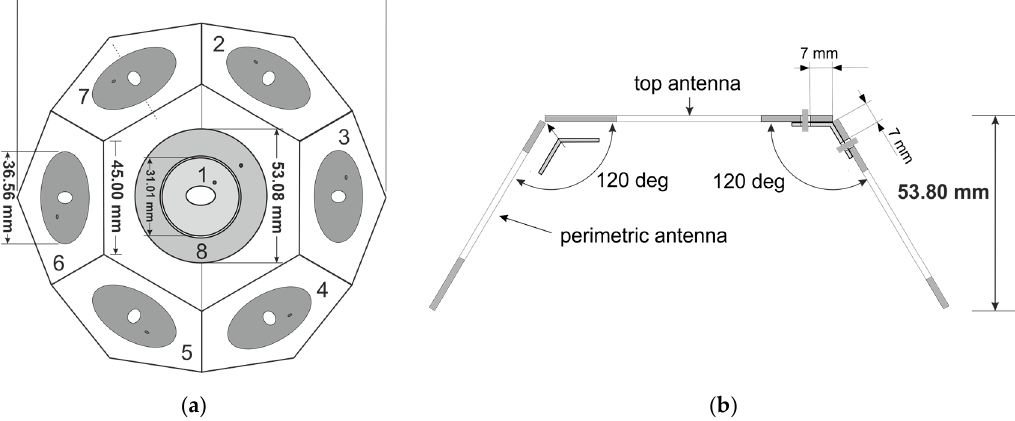
Figure 2. The mechanical structure of the Switched Beam Antenna; ( a ): top view, ( b ): side view.